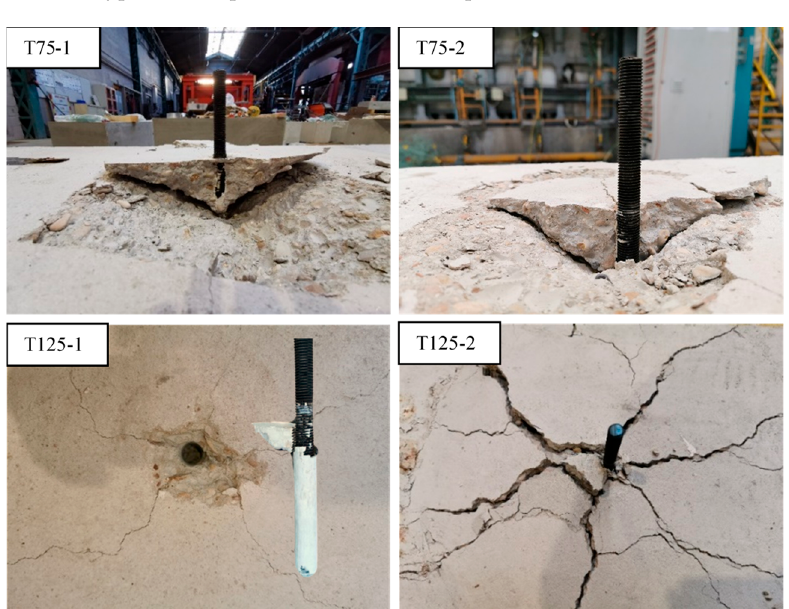
Figure 8. Crack patterns in slow-rate heating tests.